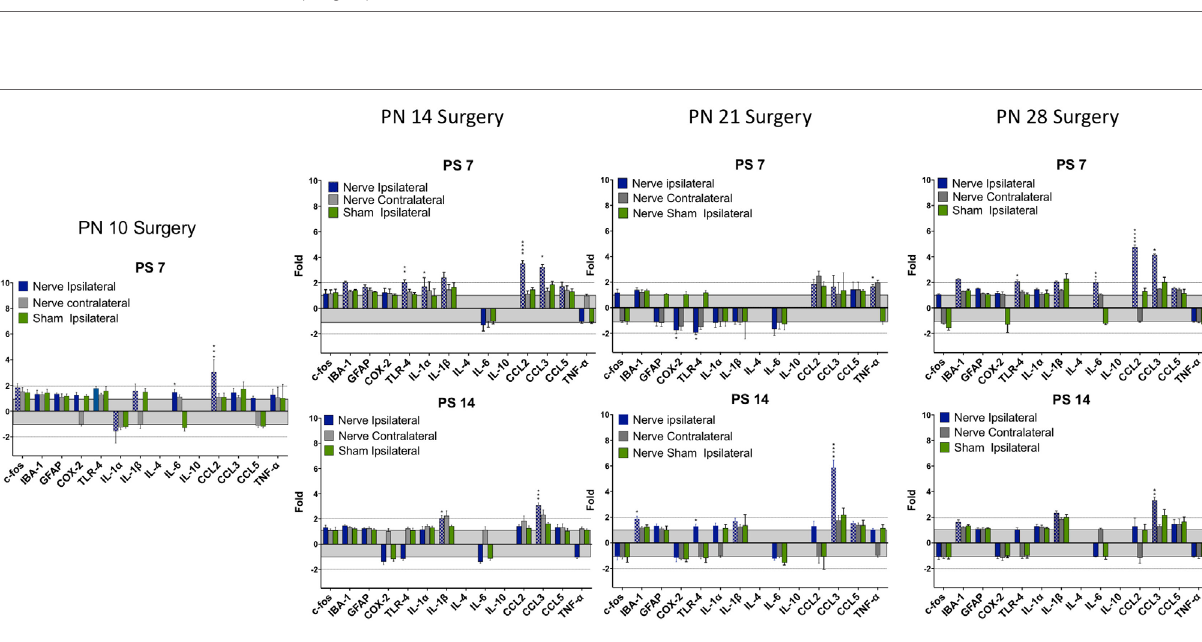
FigUre 5 | change in mrna for immune related markers, cytokines, and chemokines at different times post-nerve compression at different ages in the dorsal horn of the spinal cord . N = 4 per group. Details as in Figure 4 .